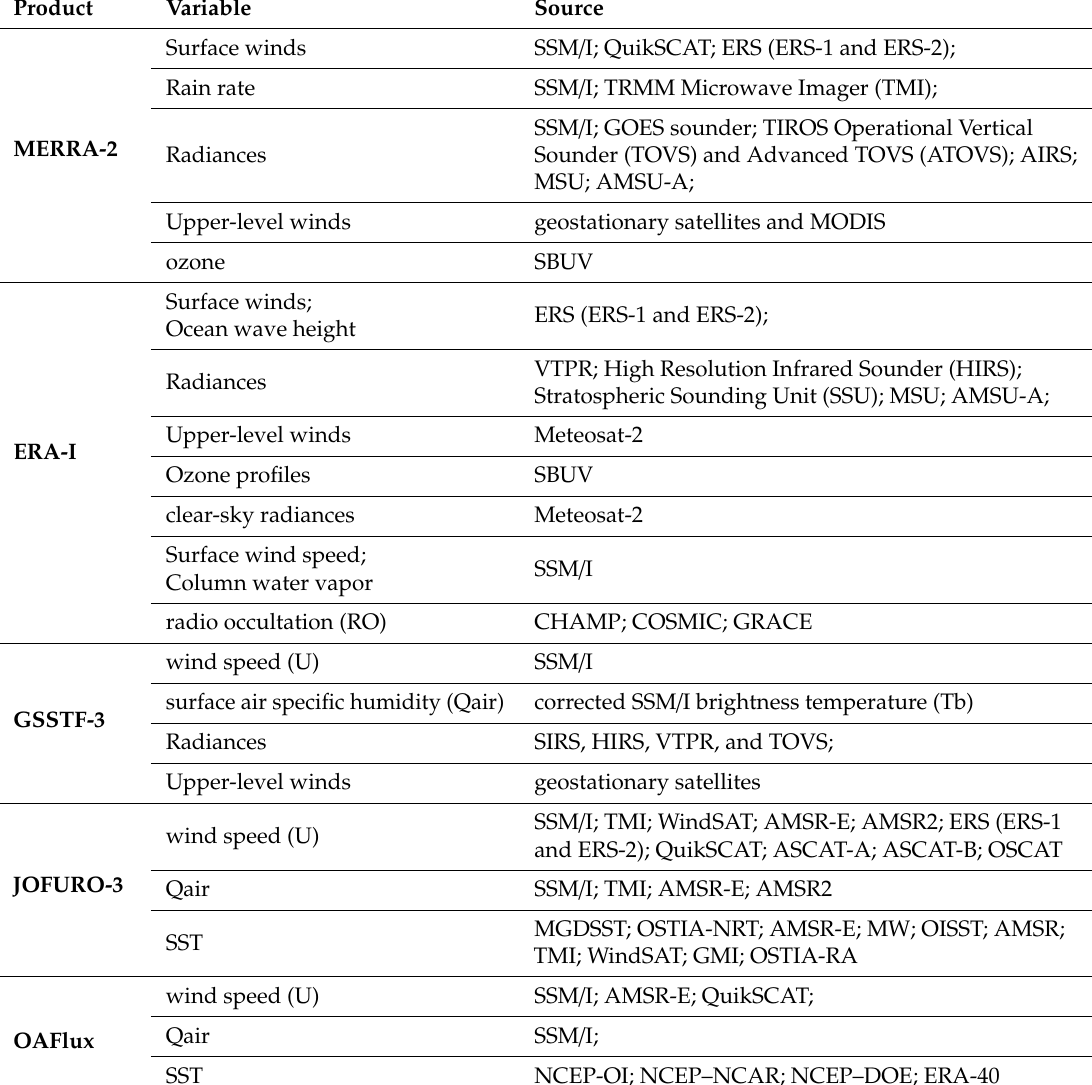
Table 2. Summary of input variable datasets for each LHF